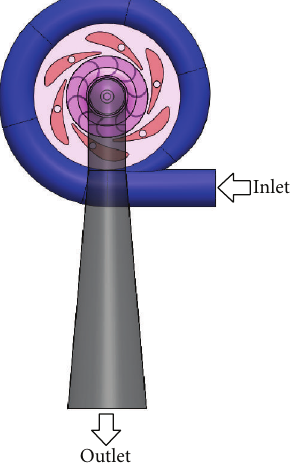
Figure 1: CAD model of Francis turbine.